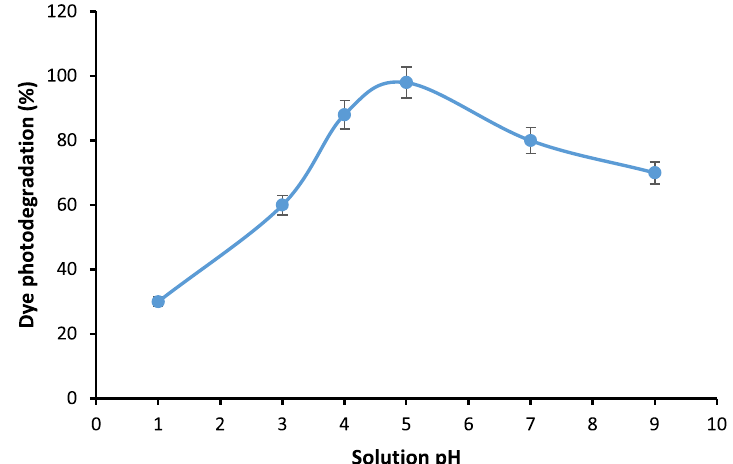
Fig. 10 Effect of solution pH (dye concentration weight 40 mg, and irradiation time =